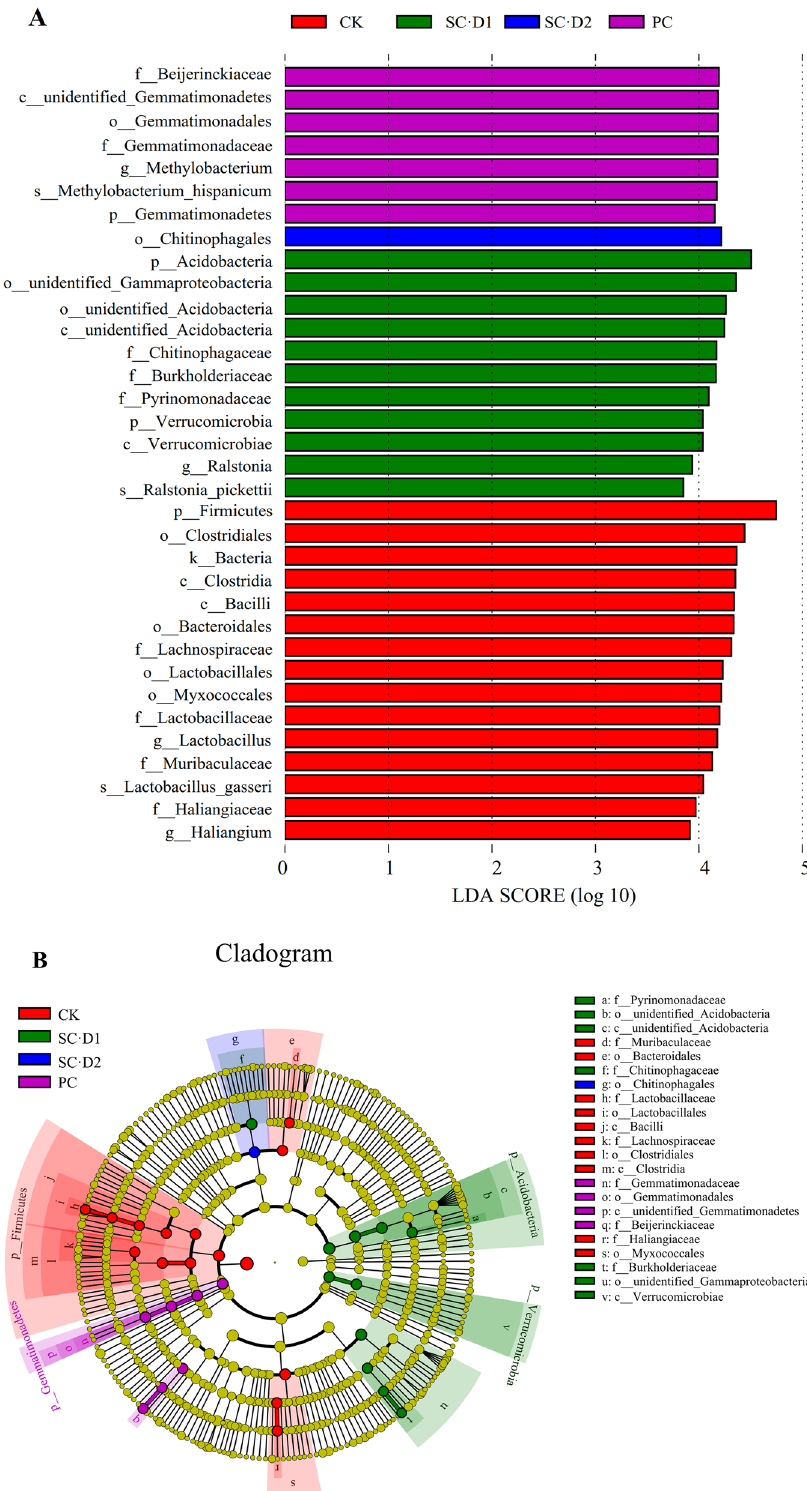
Figure 4. Line discriminant analysis effect size (LEfSe) between different treatments of the ARMR system. The circles radiating from the inside to the outside represent taxonomic levels from kingdom to species. Each small circle represents a taxon at that level, and the diameter of the small circle is proportional to the relative